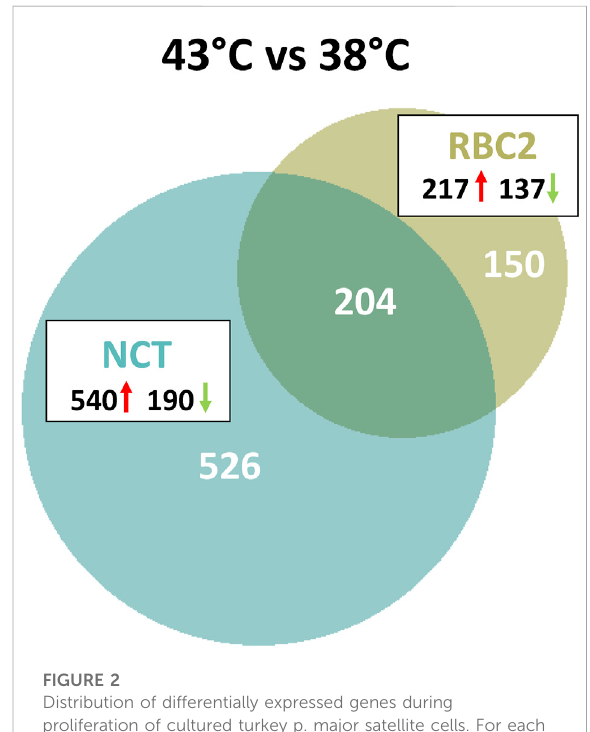
FIGURE 2 Distribution of differentially expressed genes during proliferation of cultured turkey p. major satellite cells. For each temperature comparison, the number of genes (FDR pval < 0.05 and |Log 2 FC| > 2.0) shared or unique to each line (RBC2 and NCT) are indicated in the Venn diagram. Circle size is proportional to the number of